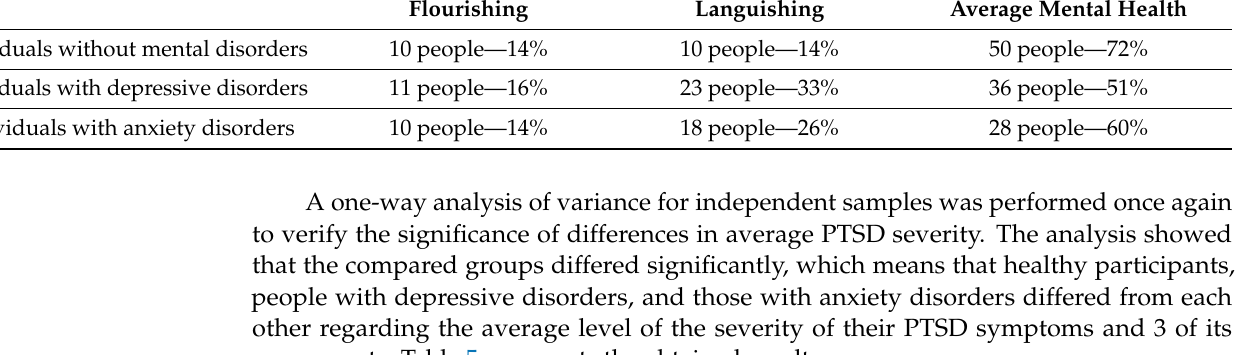
Table 5. One-way analysis of variance in the intergroup scheme of PTSD symptoms between healthy participants, partici- pants with depression, and participants with anxiety disorders. ( n = 70 in each group). No Diagnosis (1) PTSD